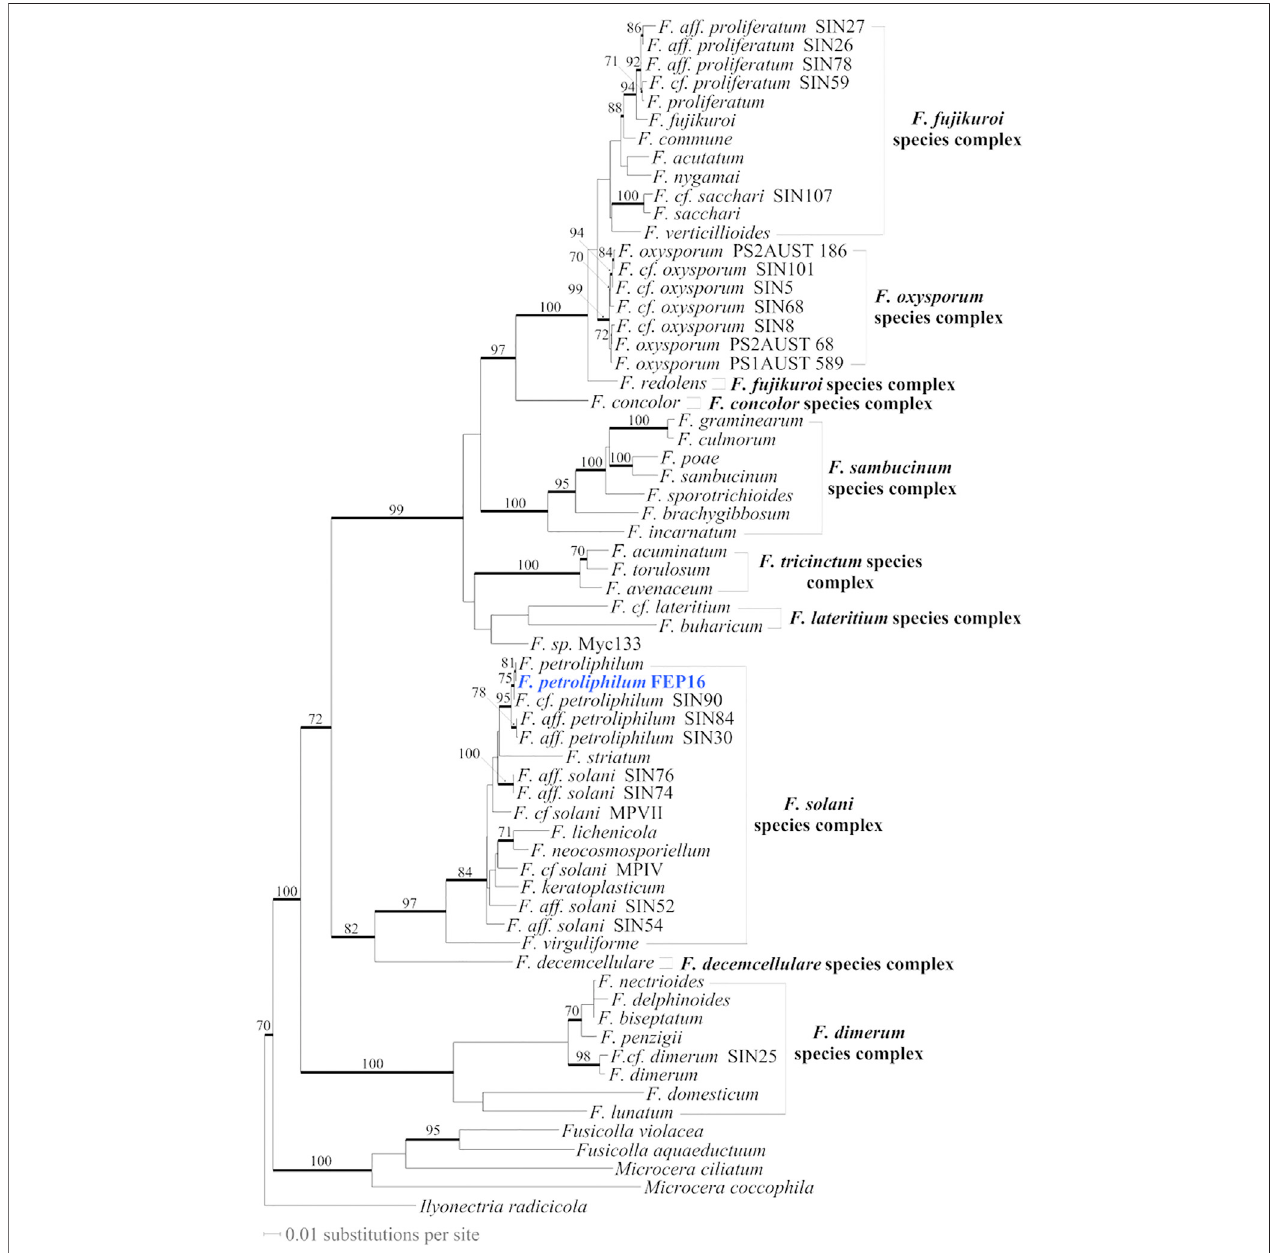
FIGURE2| Mostlikelytree(-ln (cid:1) 20922.71682)inferredfromthe Fusarium 5locus-64taxadataset(alignmentlengthafterexclusionofambiguouslyalignedregions (cid:1) 2442characters (char);calmodulin (cid:1) 142char,beta-tubulin (cid:1) 262char, ITS (cid:1) 364char, RPB2 (cid:1) 1500char, TEF-1 (cid:1) 174char).Thefungalcollection newlysequenced for that study is in blue. Branches that received signi fi cant bootstrap (BS) values ( ≥ 70%) are in bold with BS values reported along the branches.